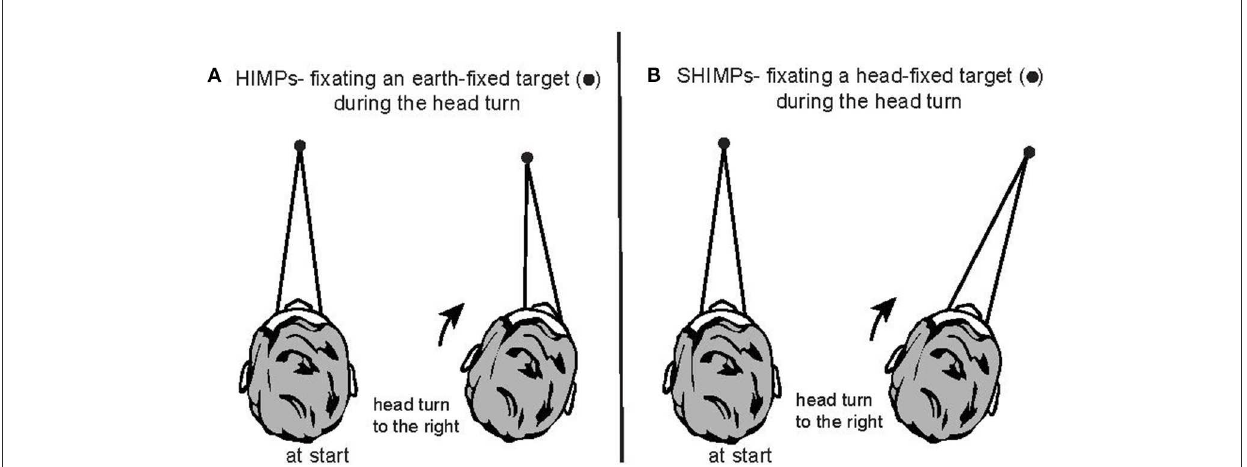
FIGURE1 Two complementary test paradigms for using vHIT to test semicircular canal function. (A) In the HIMPs paradigm the person is instructed to maintain fixation on an earth-fixed target during small, abrupt, unpredictable, passive head turns delivered by the clinician. (B) In the SHIMPs paradigm, the head movements are identical, but the person is instructed to maintain fixation on a spot on the wall projected from a head mounted laser and which therefore moves with the head. Fixation distance is around 1m in both cases.